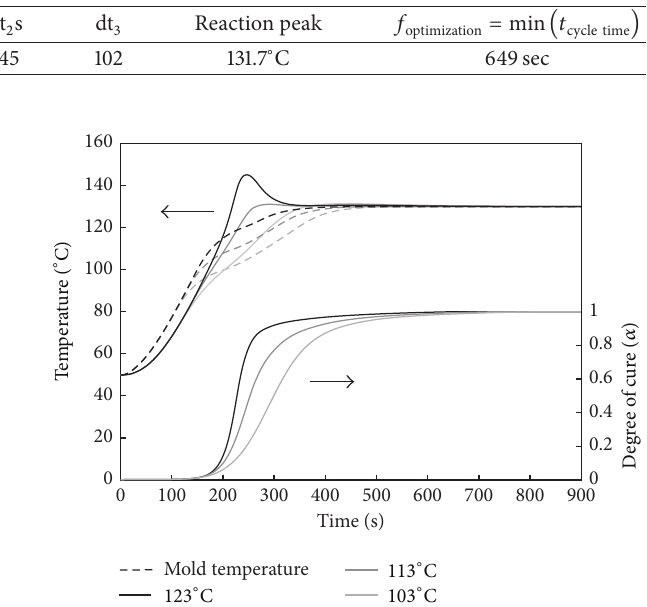
Figure 10: Comparison of cure profile between one-step and isothermal curing.